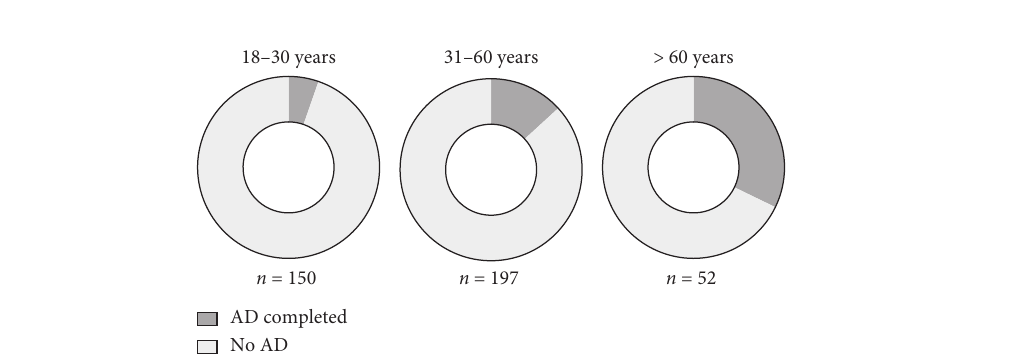
Figure 2: Percentage of patients with a completed advance directive separated into three different age groups:18–30 years, 31–60 years, and older than 60